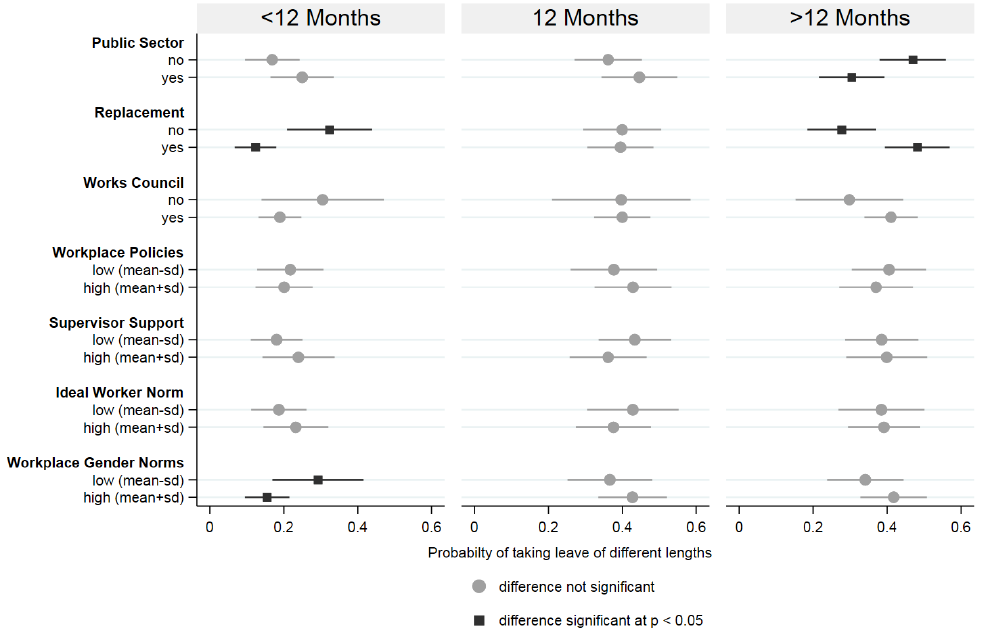
Figure 4. Predicted margins of the mothers’ likelihood of taking di ff erent lengths of leave with 95% confidence intervals. Note: N = 291. The results are based on models that are adjusted for the following covariates: age, marital status, tertiary education, partner’s tertiary education, number of children, birth year of the youngest child (as a proxy for time since the introduction of reform), region, professional position, fixed-term contract; full results available in Table A5 in the Appendix A.